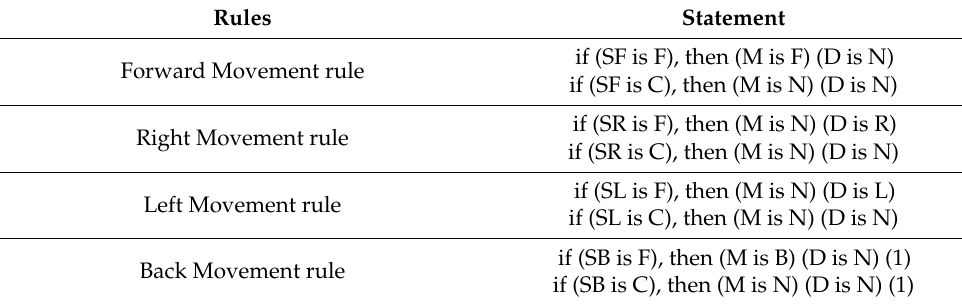
Figure 13. Defuzzification membership functions for the right and left movements. Table 3. Inference engine rules for the obstacle avoidance controller.